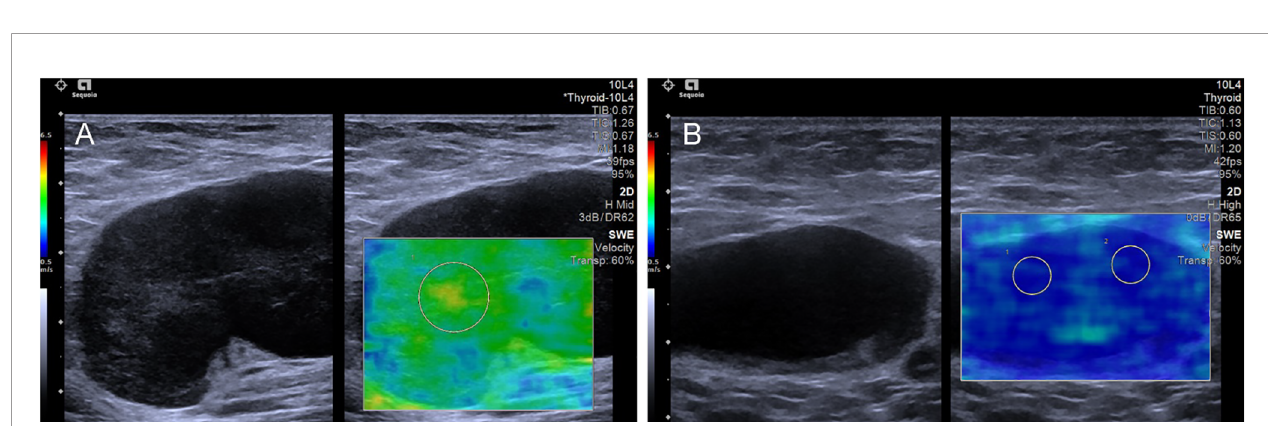
FIGURE 3 | The SWE images of benign LNs, with pathological results proven tuberculous LN (A) and nonspeci fi c lymphadenitis (B) respectively.